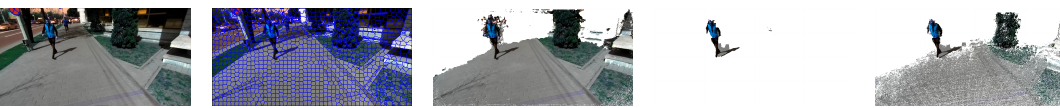
Figure 4. 3D reconstruction with outlier filtering in the presence of dynamic elements. From left to right : Image from the left camera; superpixels segmentation; accumulated point cloud; superpixels marked as dynamic; point cloud of confident and dynamic points. artifacts from the moving person and outliers from stereo correspondence and camera motion estimation are filtered out as they are not tracked over a minimum number of frames.